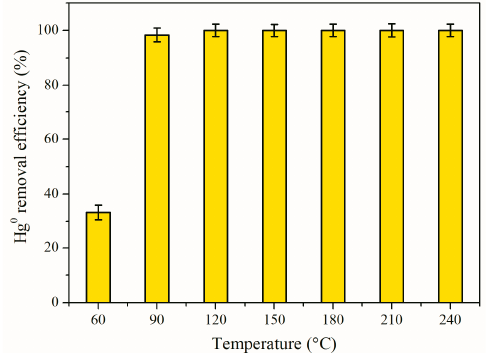
Figure 9. Impact of reaction temperature on the mercury conversion of 12Co 3 O 4 /CNNS.